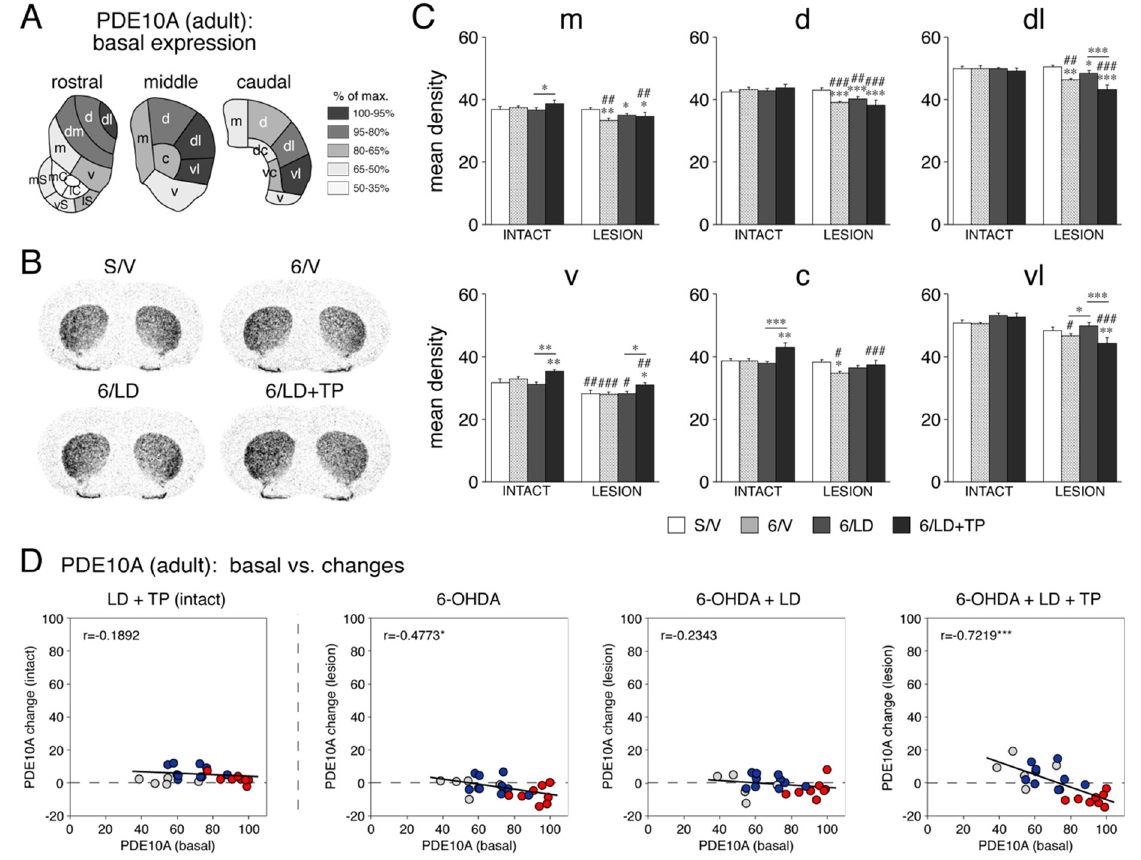
Figure 1. Basal expression (i.e., in S/V group, intact side) of PDE10A and changes in PDE10A expression after dopamine depletion and repeated treatment with L-DOPA and the PDE10A inhibitor TP-10 in the striatum of adult rats. ( A ) The topography of basal PDE10A expression in the adult striatum is illustrated by maps showing the distribution of PDE10A mRNA levels across the 23 sectors of the “rostral”, “middle” and “caudal” striatum in sham controls (S/V group) on the side contralateral to the infusion (intact side). The data are expressed relative to the maximal level observed (% of max.) and are coded as indicated. The sectors are largely based on the distribution of corticostriatal inputs (see [19]), which define functional domains. Limbic sectors (nucleus accumbens), rostral: medial shell (mS), ventral shell (vS), lateral shell (lS), medial core (mC), lateral core (lC); associative sectors, rostral: dorsomedial (dm), medial (m), ventral (v); middle: medial (m), central (c), ventral (v); caudal: medial (m), dorsal central (dc), ventral central (vc), ventral (v); sensorimotor sectors, rostral: dorsolateral (dl), dorsal (d); middle: dorsal (d), dorsolateral (dl), ventrolateral (vl); and caudal: dorsal (d), dorsolateral (dl), ventrolateral (vl). ( B ) Illustrations of film autoradiograms depict the expression of PDE10A mRNA in sections from the “middle” striatal level in sham controls (S/V), after a 6-OHDA lesion (right hemisphere) followed by vehicle treatment (6/V), after dopamine depletion followed by repeated L-DOPA treatment (5 mg/kg/day, 4 weeks; 6/LD) or after dopamine depletion followed by repeated treatment with L-DOPA plus the PDE10A inhibitor TP-10 (3.2 mg/kg/day, 4 weeks; 6/LD + TP). Animals were killed 60 min after the last injection. The maximal hybridization signal is in black. ( C ) Changes in the expression of PDE10A (mean density values, mean ± SEM) in rats of the S/V, 6/V, 6/LD or 6/LD + TP groups are given for the medial (m), dorsal (d), dorsolateral (dl), ventrolateral (vl), central (c) and ventral (v) sectors on the side ipsilateral (LESION) and contralateral (INTACT) to the lesion, on the middle striatal level. * p < 0.05, ** p < 0.01, *** p < 0.001 vs. S/V or as indicated; # p < 0.05, ## p < 0.01, ### p < 0.001 vs. same group on intact side. ( D ) The